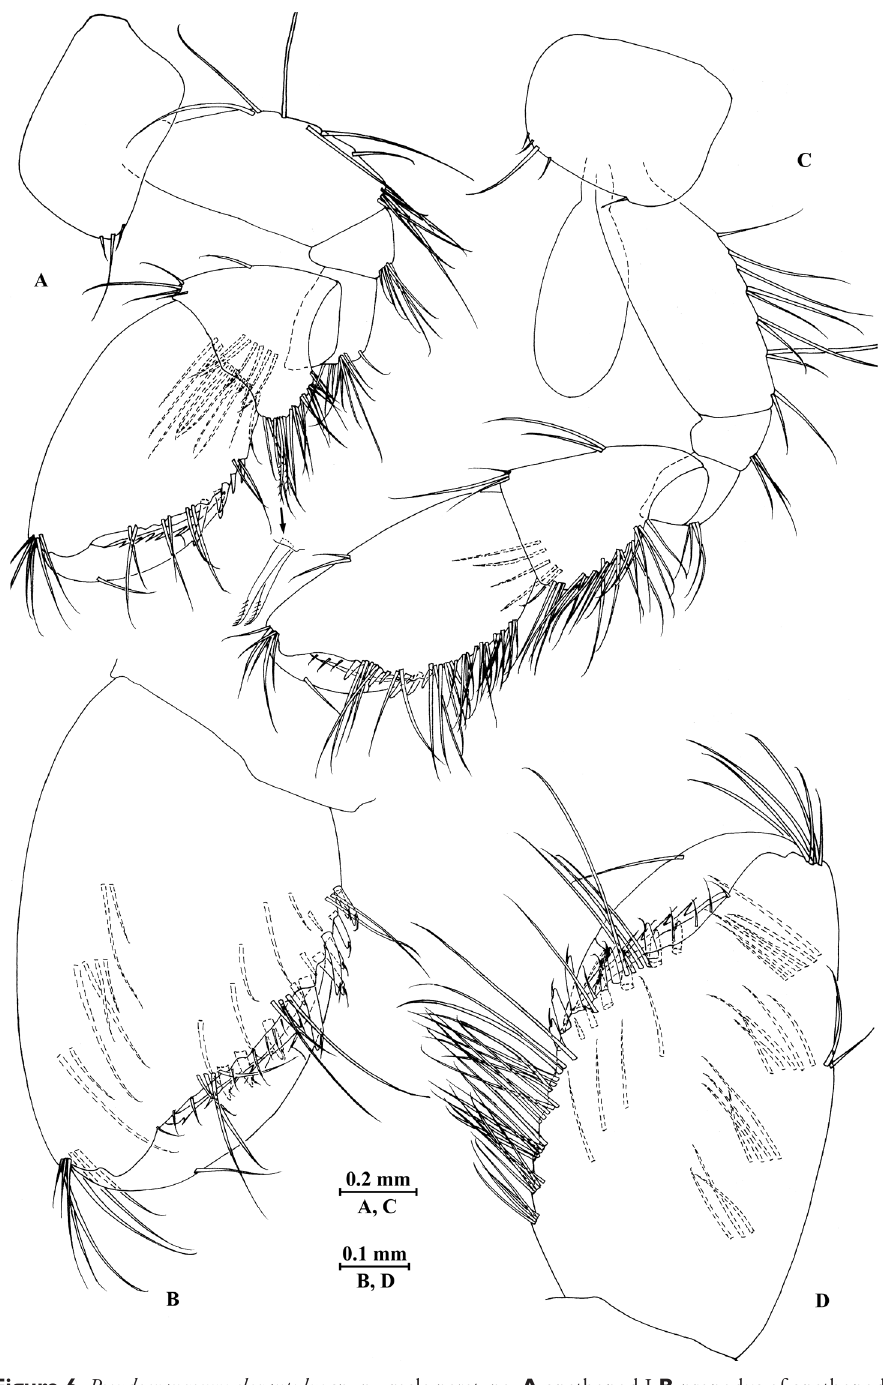
Figure 6. Pseudocrangonyx elegantulus sp. n., male paratype. A gnathopod I B propodus of gnathopod I C gnathopod II D propodus of gnathopod